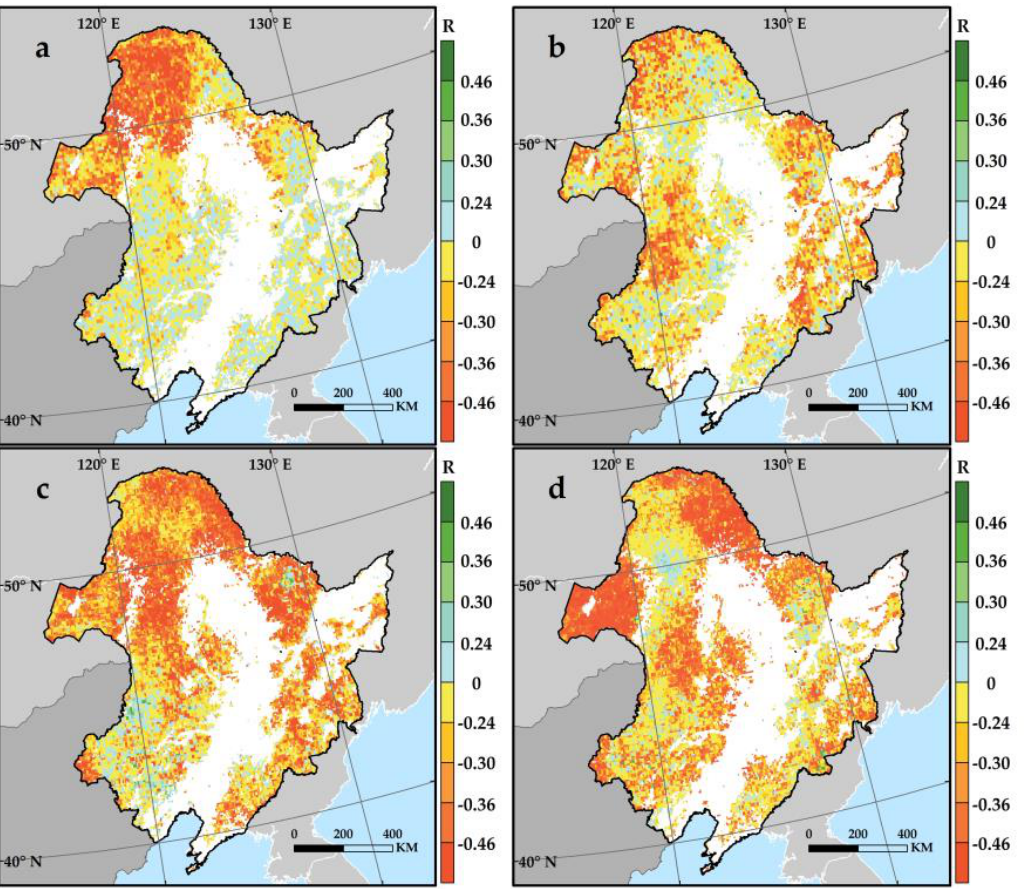
Figure 6. Spatial distribution of partial correlation coefficients between ( a ) VGFDs and Vgreenup; ( b ) VWFDs and Vwithering; ( c ) average AFDD VG and Vgreenup; ( d ) average AFDD VW and Vwithering. The 1%, 5%, 10%, and 20% significance levels of the partial correlations correspond to ± 0.46, ± 0.36, ± 0.30, and ± 0.24, respectively.